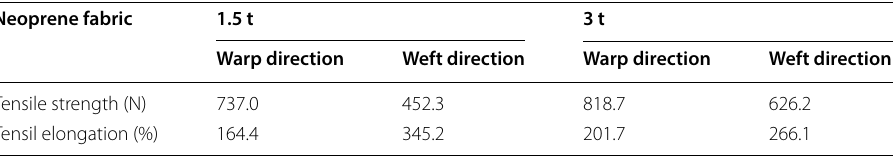
Table 3 Results from the testing of fabric tensile strength Neoprene fabric 1.5 t Warp direction Weft direction Warp direction Weft direction Tensile strength (N)